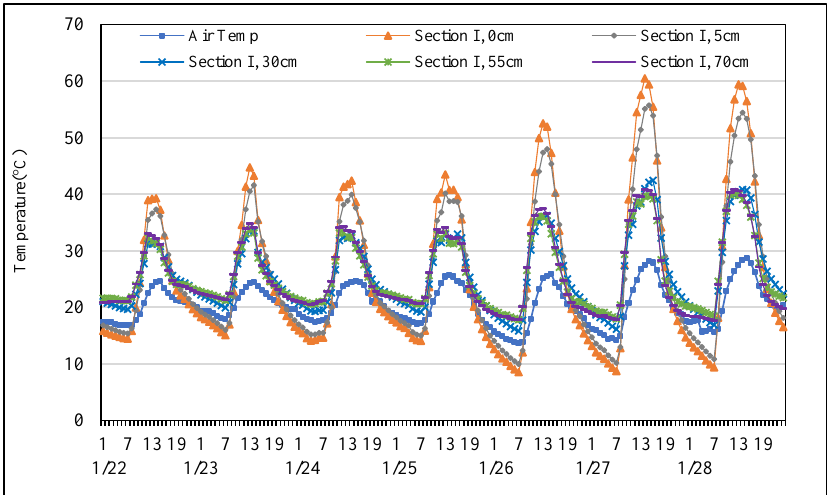
Figure 4. Temperature distribution at each depth of Section I from the 22nd to the 28th of January.